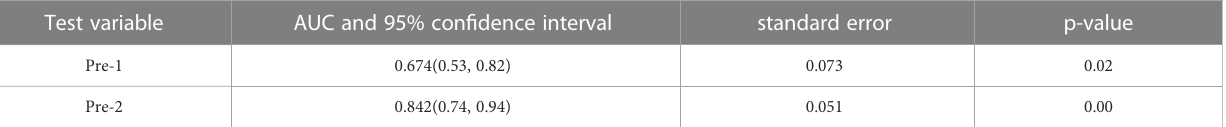
TABLE 6 Results of ROC curve analysis using SPSS.